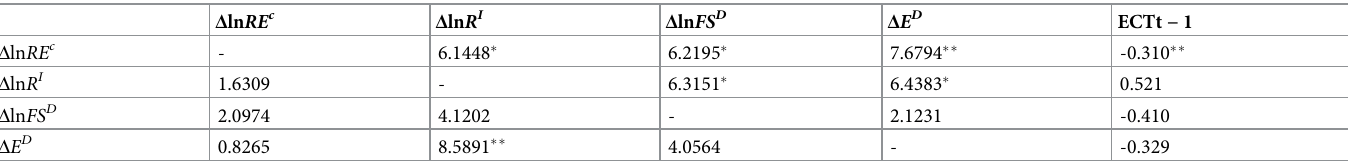
Note � , �� denote significance at 1, and 5%